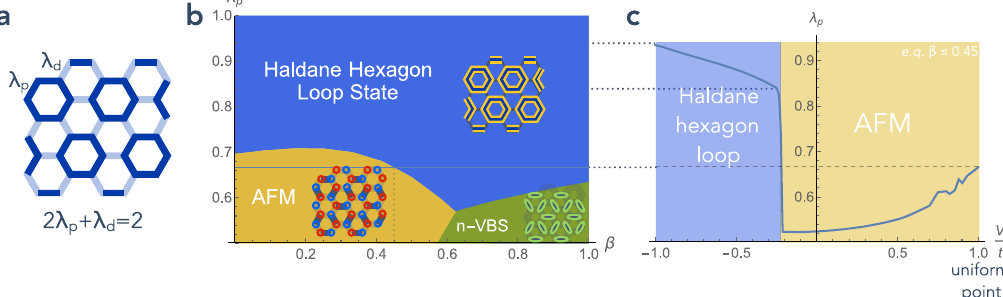
¼ 2 and the loop constraint impose λ d = 2(1 − λ p ). b Phase i